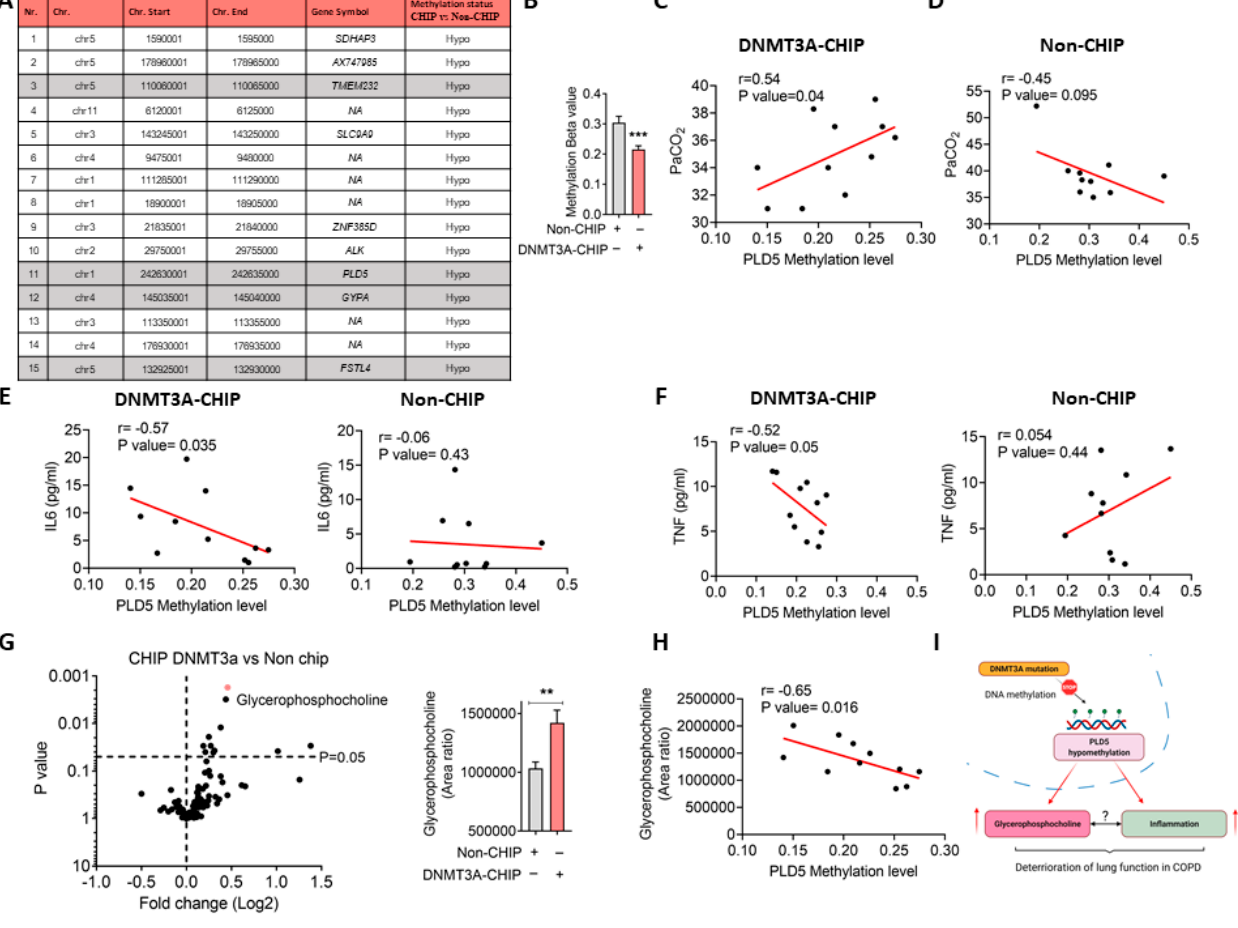
list; Table S3: List of primary antibodies; Table S4: DNMT3A SNPs; Table S5: Methylation level of inflammatory markers. Supporting information can be found in supplementary materials